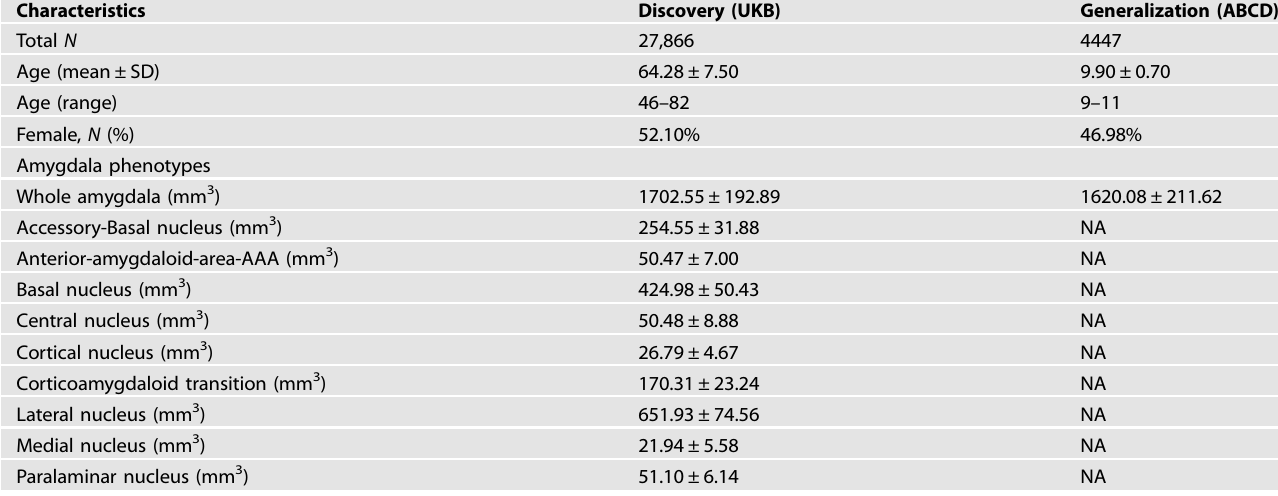
Table 1. Samples and phenotype